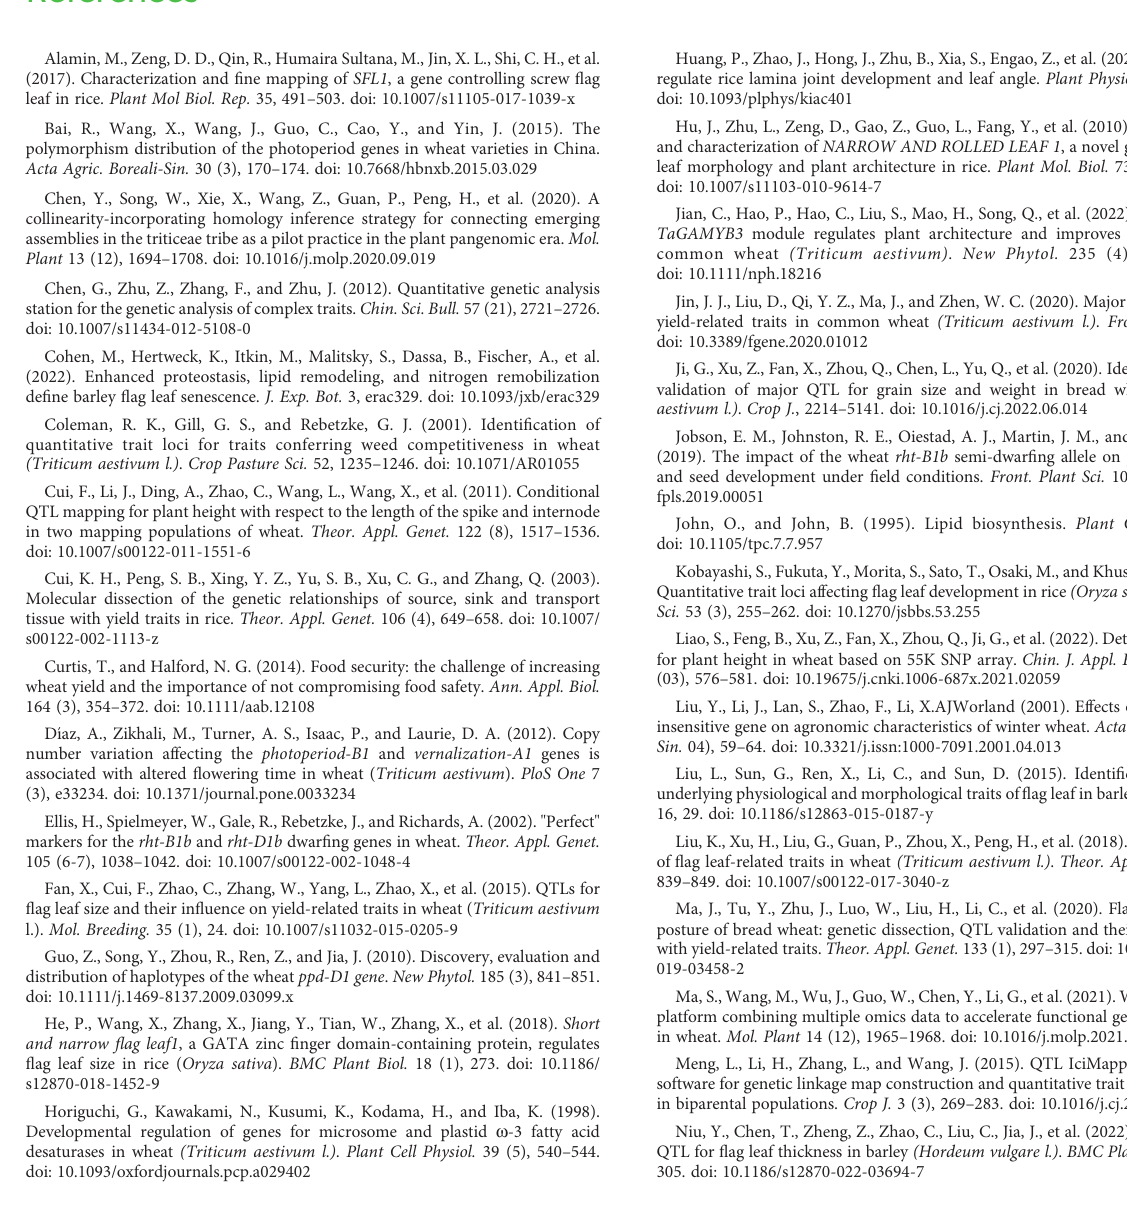
SUPPLEMENTARY FIGURE 6 QTL analysis (A) , genetic map (B) , and physical map (C) of QFll/Flw/ Fla.cib-2D SUPPLEMENTARY FIGURE 7 QTL analysis (A) , genetic map (B) , and physical map (C) of QFll/Fla.cib-2B SUPPLEMENTARY FIGURE 8 Effect analysis of QFll/Fla.cib-2B (A) , QFlw.cib-4B.3 (B) , and QFll/Flw/ Fla.cib-2D (C) on grain yield per plant (GYP) in WC12 population. W7268 and CY12 represent lines with alleles from W7268 and CY12, respectively; *,**,***,and****representsigni fi cantat P <0.05, P <0.01, P <0.005,and P < 0.001,